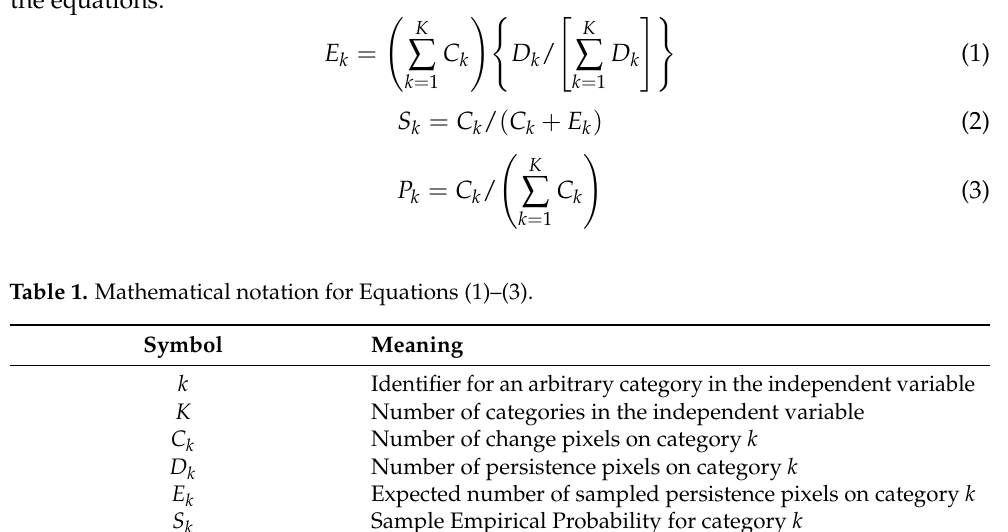
Sample Empirical Probability for category k P k Population Evidence Likelihood for category